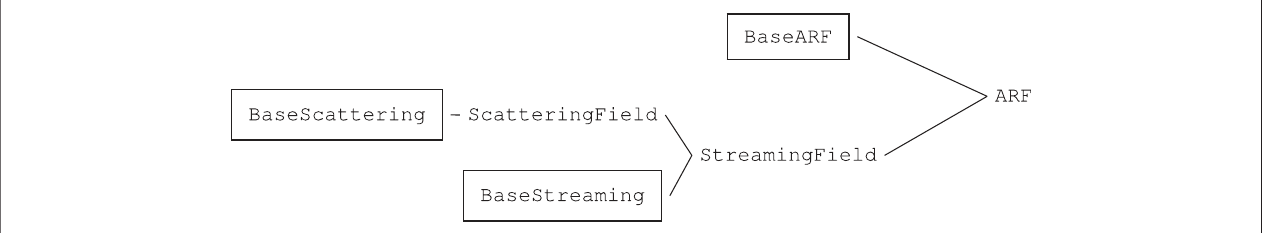
FIGURE 1 | Inheritance diagram for model which has a scattering solution, a streaming solution, and an ARF solution. The boxed classes represent base classes given within the library.